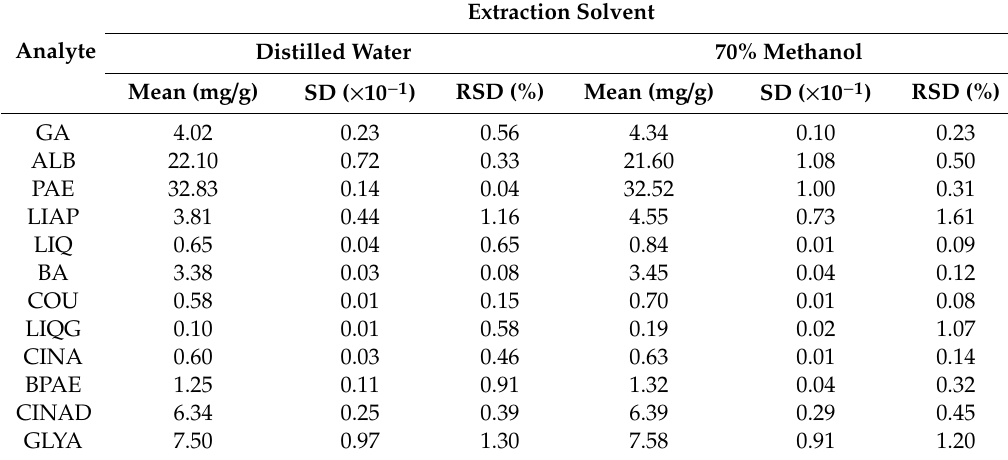
Table 4. Amounts of the 12 marker analytes in SGJT according to extraction solvents (n = 3).